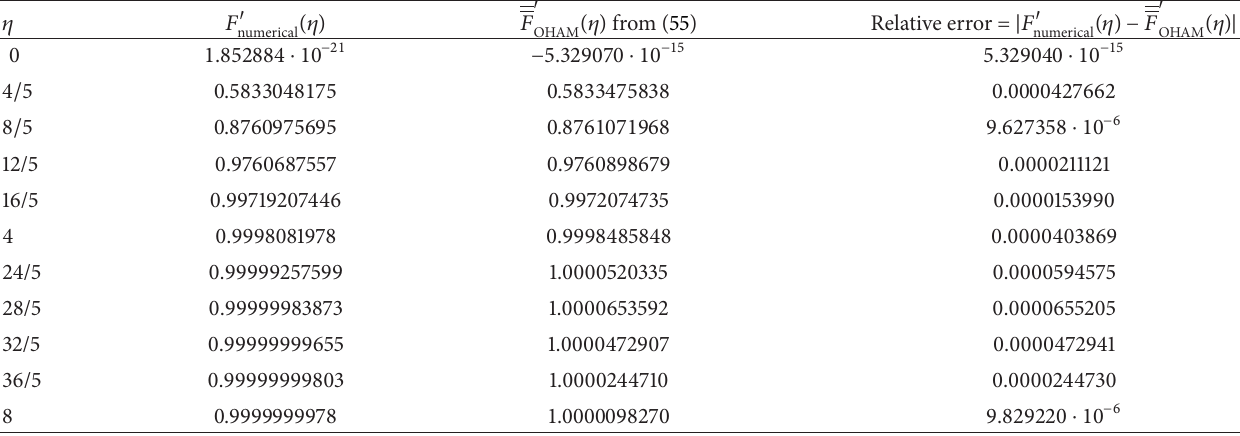
󸀠 (𝜂) obtained from (55) and numerical results for 𝛽 = 1/2 .